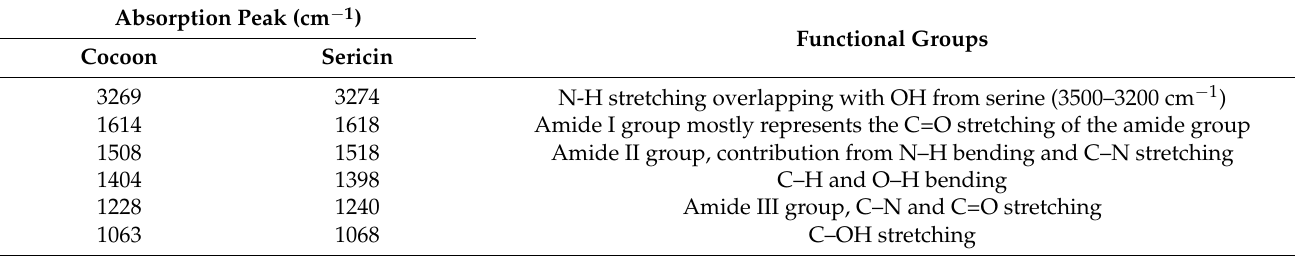
Table 1. FTIR absorption peaks of cocoon and sericin.